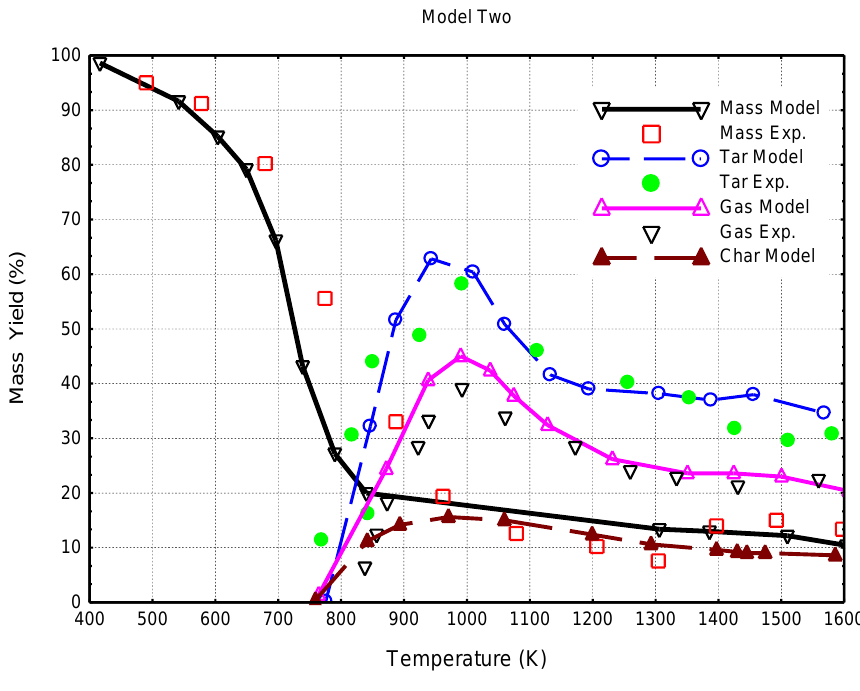
Figure 4. Simulations of gasification and/or devolatilization model 2 (M2) and experimental measurements (using Nunn et al. [50]) for a mass yield of gases, char, and tar of powder biomass at fast heating rate conditions in combustion engines.